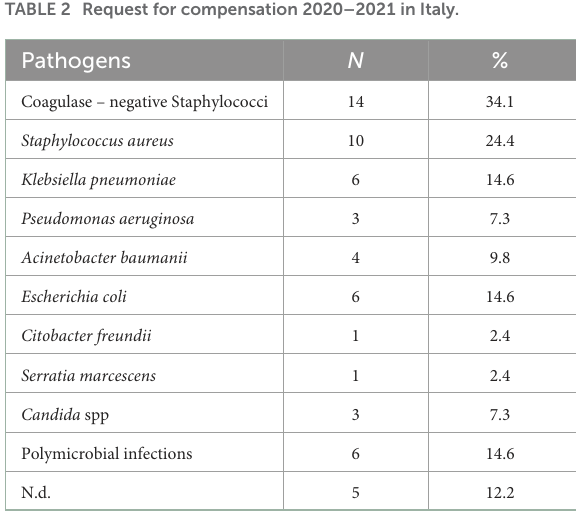
TABLE 2 Request for compensation 2020–2021 in